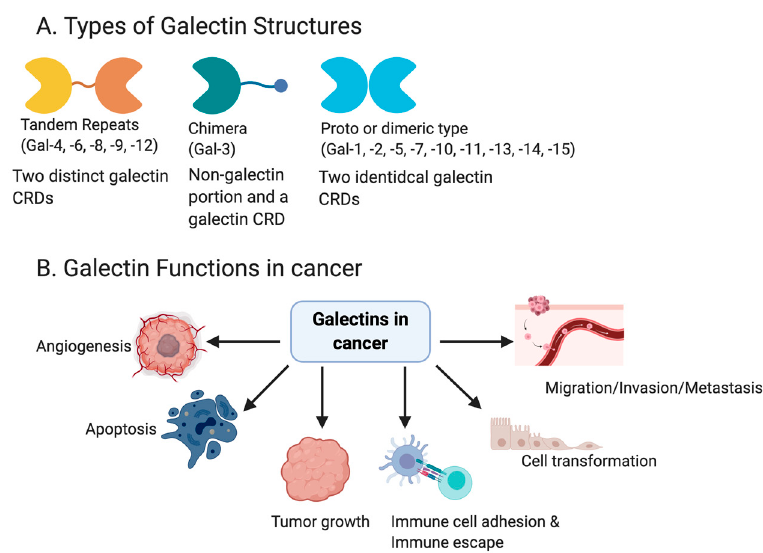
Figure 1. A schematic showing the different galectin structures and members of each ( A ). Galectins have been shown to play a role in altering many functions in cancer, including angiogenesis, apoptosis, tumor growth, immune escape, immune cell adhesion, cell transformation and metastasis/invasion ( B ).